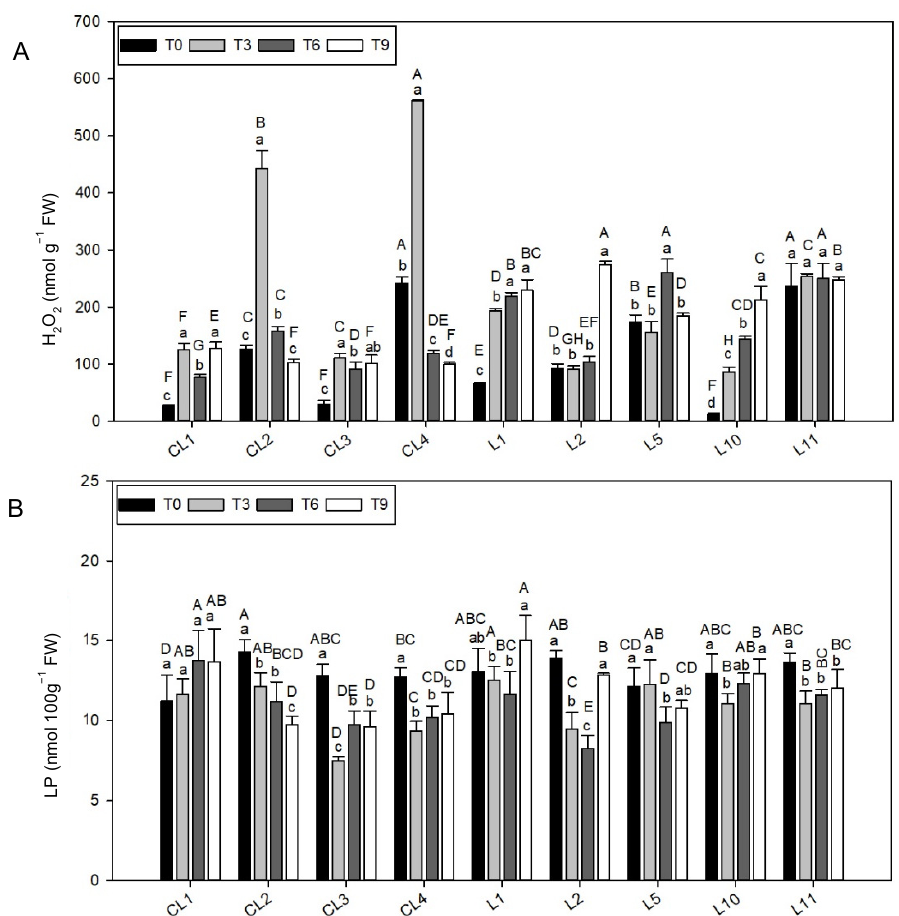
Figure 4. The ( A ) hydrogen peroxide (H 2 O 2 ) content and ( B ) lipid peroxidation (LP) in the nine lettuce varieties evaluated at 0 (T0), 3 (T3), 6 (T6) and 9 (T9) days after conservation under chamber conditions. Values are the mean ± SE of four replicates per landrace. The mean is subjected to a one-way ANOVA. Different capital and lowercase letters indicate significant differences between varieties and development stages, respectively, at p < 0.05 by the LSD test. FW: Fresh weight.